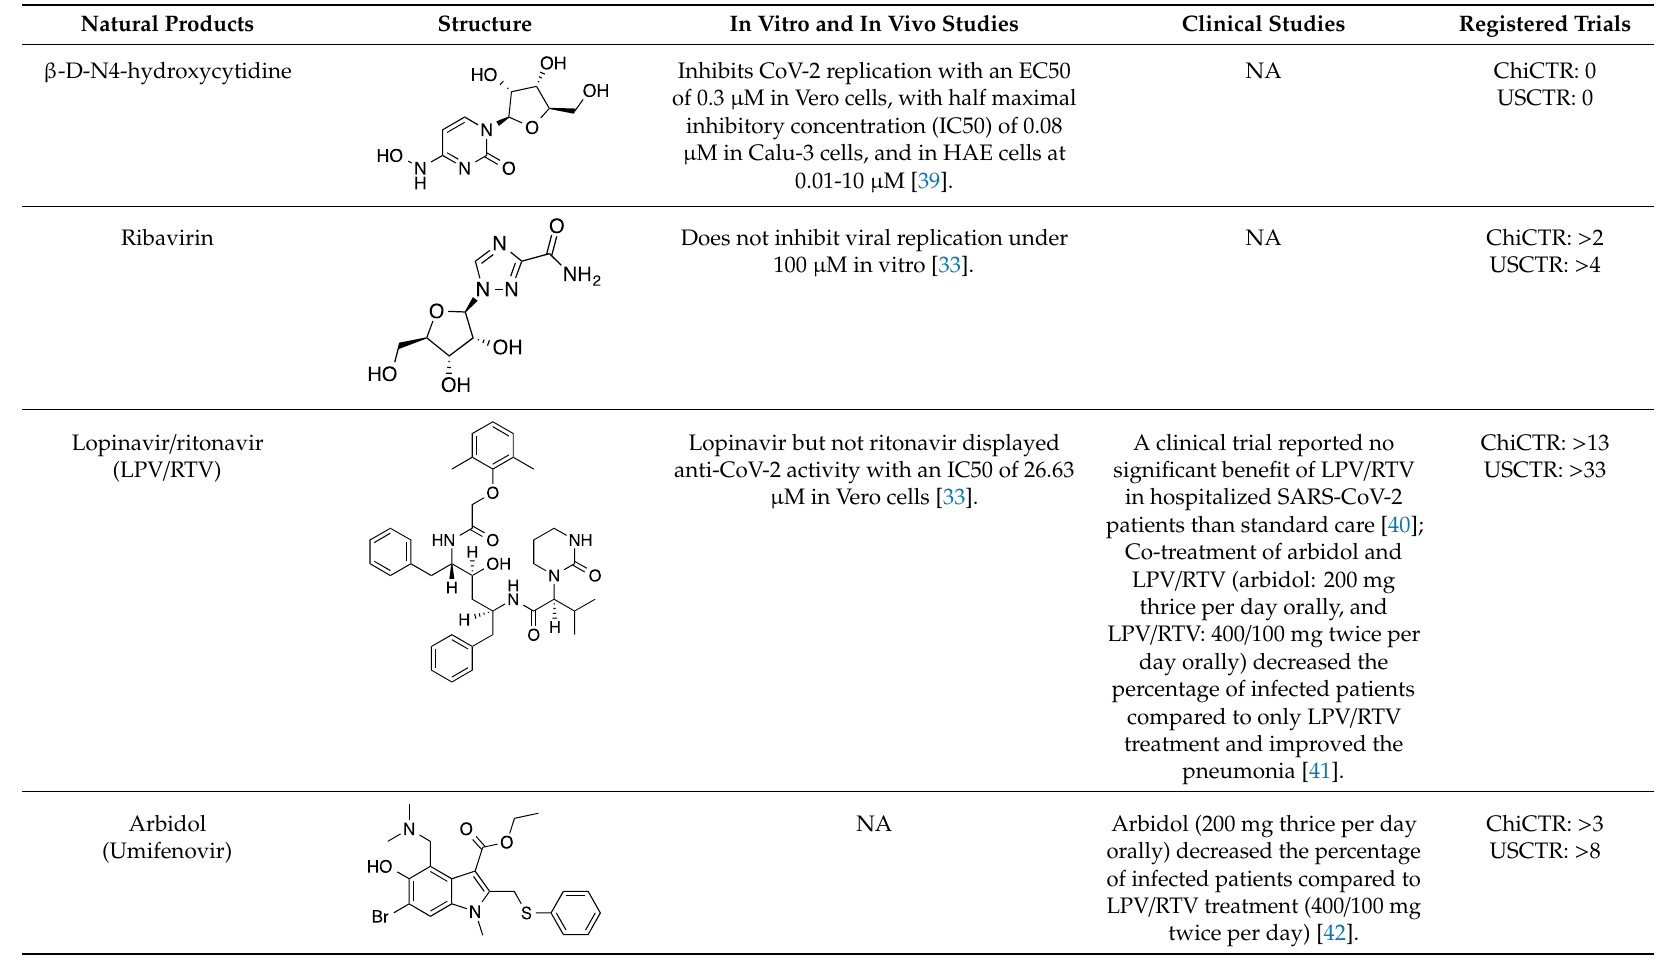
percentage of infected patients compared to only LPV / RTV treatment and improved the pneumonia